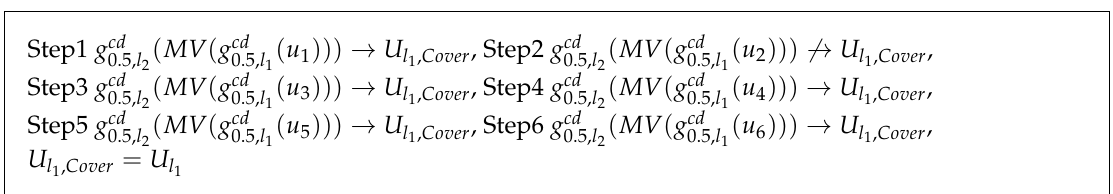
The decision system ( U l